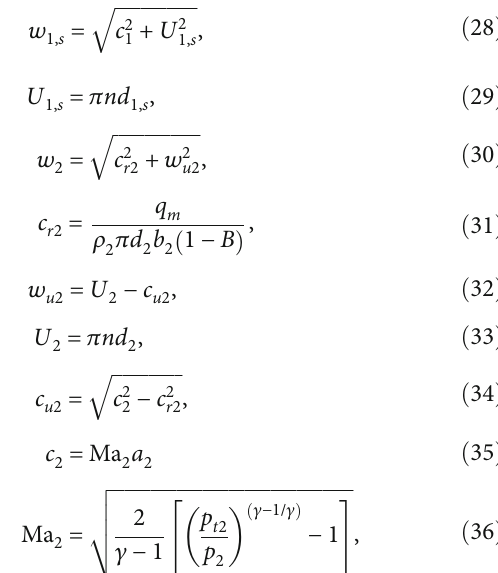
Table 4: Parameters of the studied centrifugal compressor at the point of maximum axial thrust (point 9) used in the method proposed by Larjola.